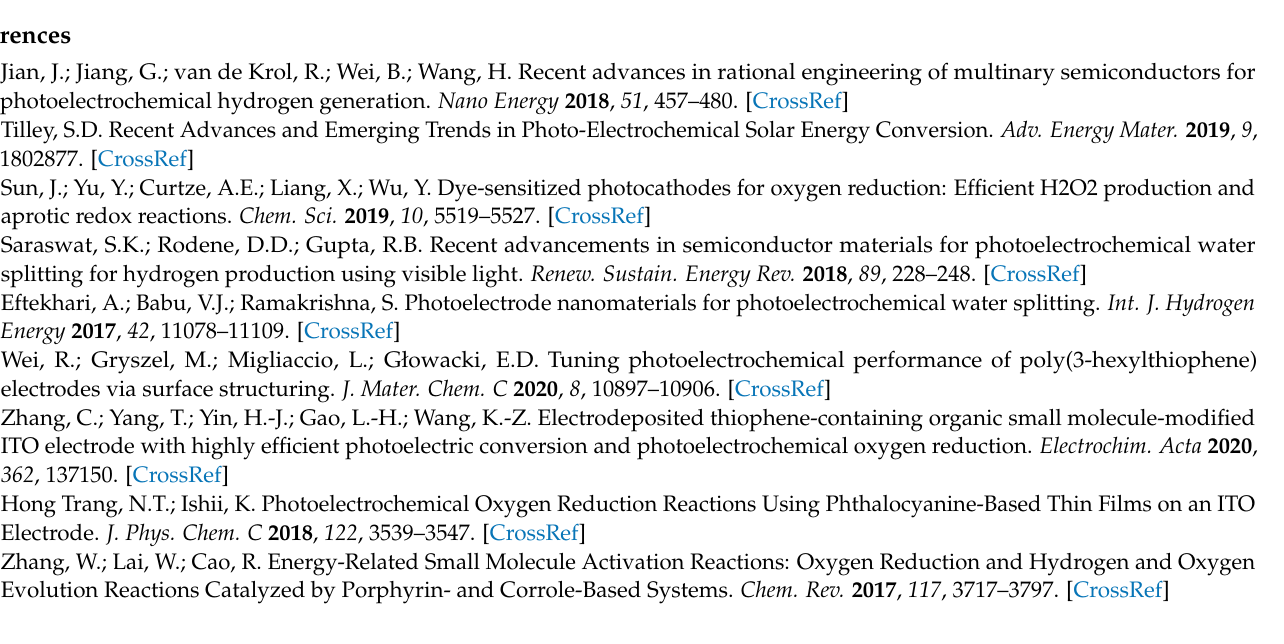
Figure S2: 13C NMR spectrum of meso-tetra-(4-sulfonatophenyl)-porphin (TPPS); Figure S3: UV-Vis spectrum of 0.2 µ M TPPS in deionized water; Figure S4: Fourier transform infrared (FT-IR) spectra of TPPS-doped polypyrrole (PPy-L) and CoTPPS-doped polypyrrole (PPy-C); Figure S5: Energy- dispersive X-ray spectrum of PPy-C; Figure S6: LSV curves of PPy-films synthesized with (A) 31 mC/cm2 and (B) 21 mC/cm2. under illumination (solid lines) and without illumination (dashed lines) in 0.1 M Na2S2O3; Figure S7: Linear sweep voltammetry of PPy-L and PPy-C in phosphate buffer pH 7.0. Scan rate 5 mV/s. (A) PPy over-oxidation during the first LSV. (B) Water oxidation after the degradation (over-oxidation) of polypyrrole; Figure S8: UV-Vis characterization of PPy- ClO4, PPy-L and PPy-C before (A) and after (B) photoelectrochemical test under cathodic conditions; Figure S9: Raman characterization of PPy-ClO 4 , PPy-L and PPy-C before (continuous lines) and after (dashed lines) photoelectrochemical test under cathodic